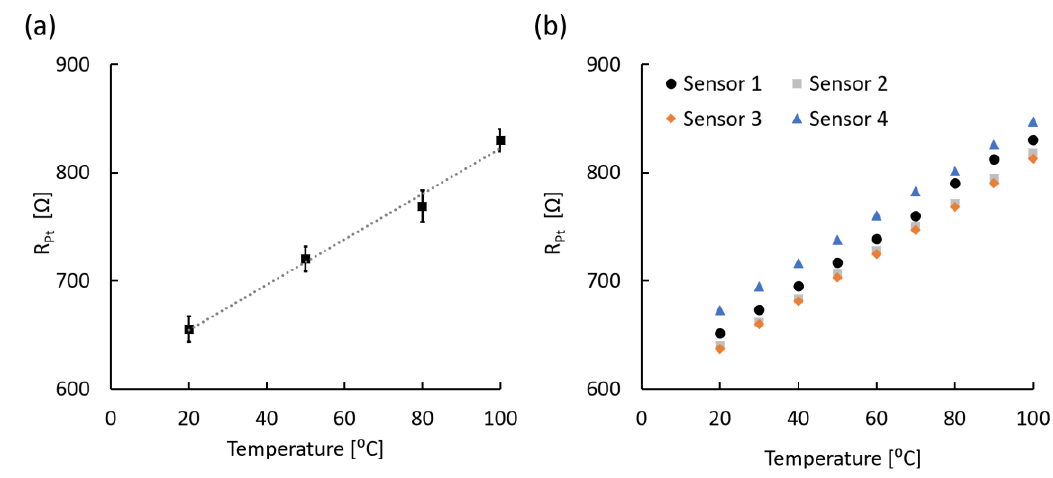
Figure 5. Linear resistance change of developed sensors depending on temperature change between 20 and 100 °C. ( a ) Averaged resistance plot with linear regression (dotted line; R 2 > 98%; N = 20). Error bars represent the standard deviation (SD). ( b ) Four examples of resistance of independent sensors from multiple batches.